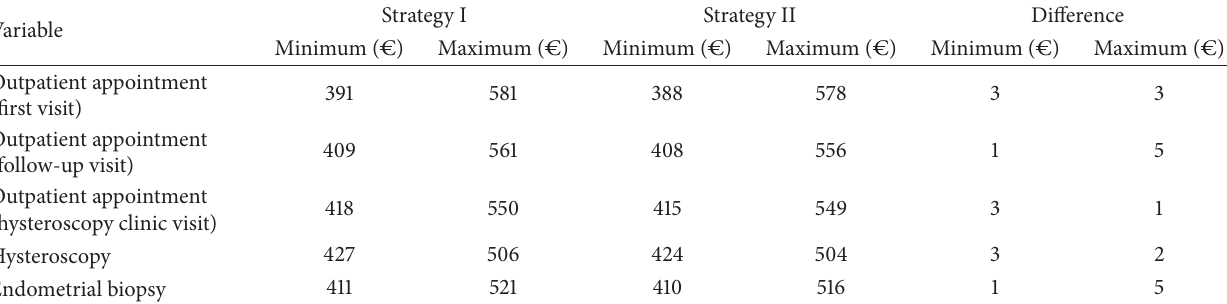
Table 3: Sensitivity analysis: minimum and maximum expected costs and cost-difference for 65% cut-off